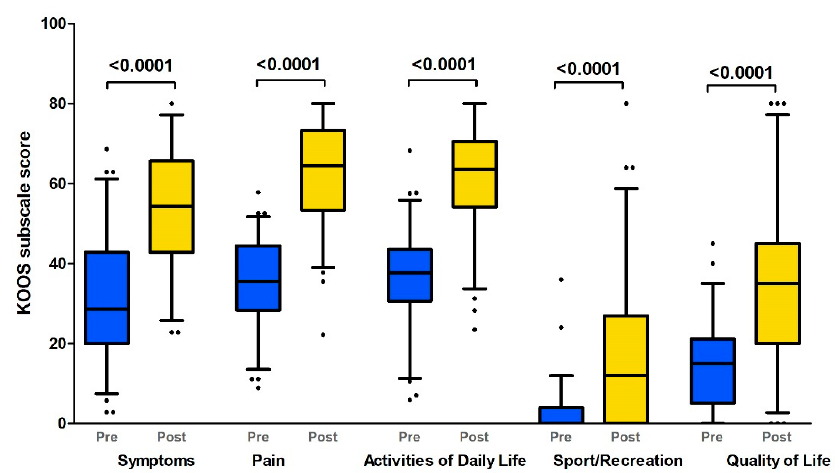
Figure 1. KOOS profiles prior to and 12 months after TKR (Boxplot with 10th–90th percentiles). KOOS subscales: pain; symptoms; activities of daily living; sport and recreation; quality of life (Wilcoxon paired test p -values). Pre: preoperative status; Post: postoperative (1 year after TKR) status. Table 2. uC2C, KOOS, SF-36, and lower limb performance test results in the pre- and postoperative periods.